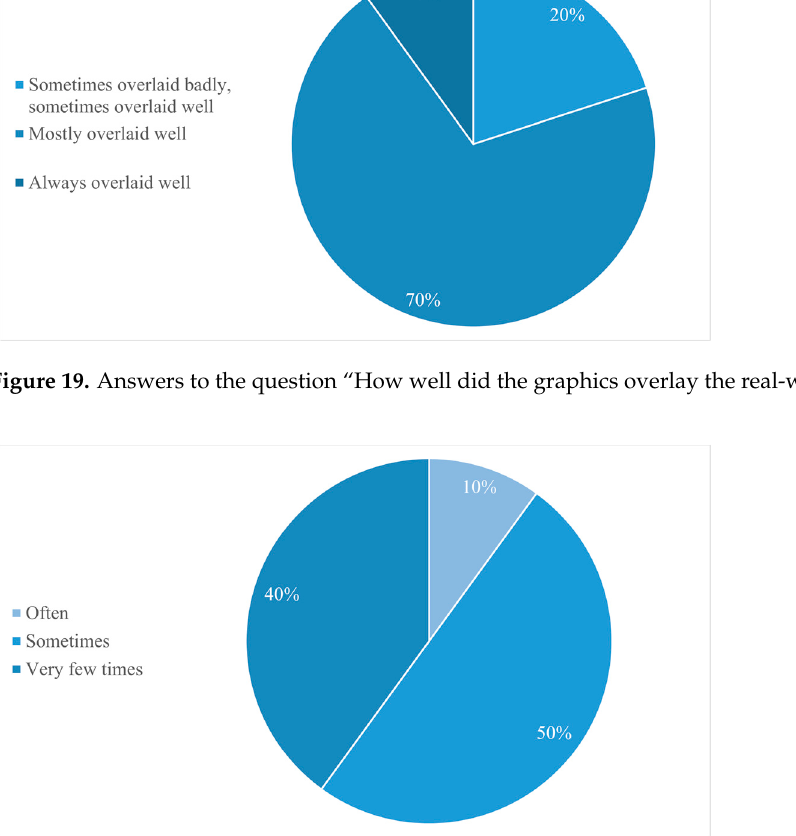
Figure 21. The participants’ perception of other guidance formats in the MR app.